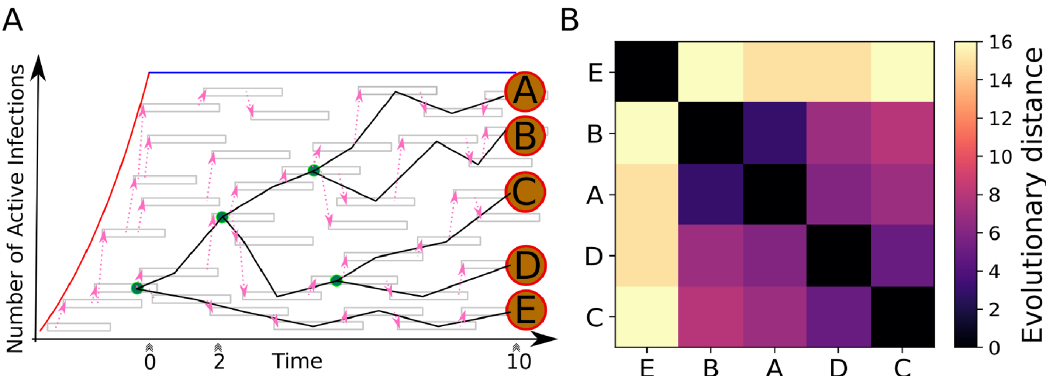
Fig 1. (A) Cartoon representation of the biphasic forward stochastic simulation. The red line indicates the exponential phase, the blue line indicates the constant population phase. Grey boxes represent an infected individual, pink arrows indicate transmission. The reconstructed transmission dendrogram is overlaid, green nodes are internal, orange (lettered) nodes indicate sampled infections. Triple chevrons indicate different possible sampling times (0, 2, 10 years). (B) The resulting image representation of the sorted pairwise distance matrix sampled at Year